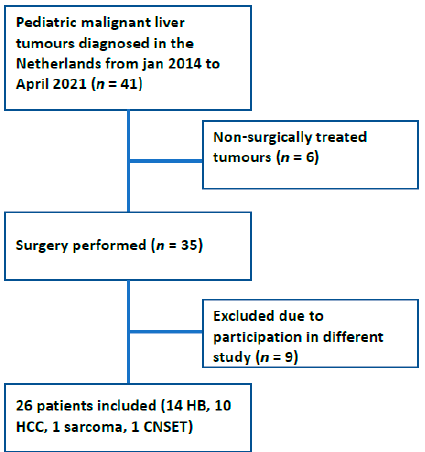
Figure 1. Flow chart of inclusion and exclusion. HB: hepatoblastoma; HCC: hepatocellular carcinoma; CNSET: calcifying nested stromal epithelial tumour. Table 1. Patient characteristics.